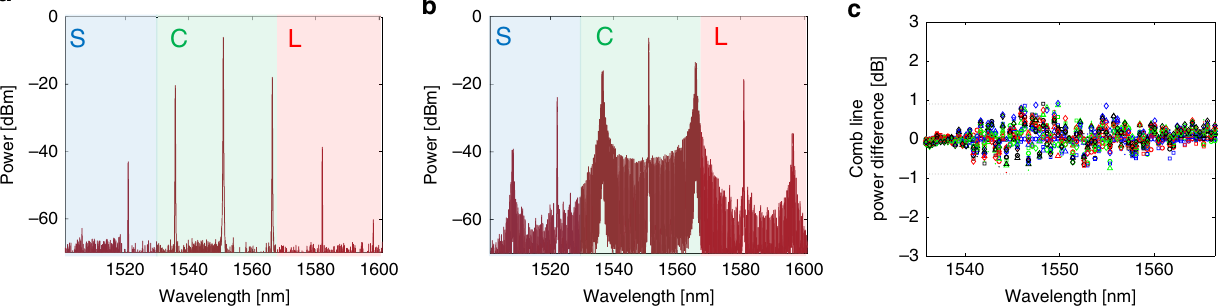
Fig. 2 Soliton crystal generation. To generate a soliton crystal, a laser is slowly tuned from the red side of a resonance to a pre-set wavelength. a A primary comb (Turing pattern) is initially generated as the laser is tuned into resonance with the ring. b Spectrum of the soliton crystal oscillation state used for experiments. The state had a characteristic ‘ scalloped ’ micro-comb spectrum, corresponding to the single temporal defect crystal state illustrated over the ring. At the pre-set wavelength, a soliton crystal forms, with spectral features based around the primary comb lines. The state that we use provides comb lines over most of the optical communications C-band. c Soliton crystal comb line power difference for 10 independent crystal generation instances (different symbols indicate distinct generation instances). Comb line powers remain within ± 0.9 dB of the initial spectrum, indicating reliable generation of the desired soliton crystal state. Fig. 4a indicates a 20% soft-decision forward error correction 40.1 Tb/s (in B2B), dropping to 39.2 Tb/s and 39.0 Tb/s for (SD-FEC) threshold given at a BER of 4 × 10 − 2 from a demon- the lab and fi eld-trial transmission experiments, respectively. strated code 37 . All results were below the given FEC limit, but These yielded spectral ef fi ciencies of 10.4, 10.2, and 10.1 b/s/Hz since using SD-FEC thresholds based on BER is less accurate (see Methods). These data rates represent an increase of ~50% for higher-order modulation formats and for high BERs 38 , we (see Methods) over the highest reported result from a single additionally used generalised mutual information (GMI) to cal- integrated device 28 , whereas the spectral ef fi ciency is 3.7 times higher. This is notable considering that the experiments were culate the system performance. Figure 4b plots the GMI for performed with the added penalty of full comb fl attening each channel and its associated SE, with lines given to indicate (equalisation, even though this is in fact not necessary 39 ), and projected overheads. We achieved a raw bitrate (line-rate) of 44.2 Tb/s, which translates to an achievable coded rate of without closed-loop feedback or stabilisation.